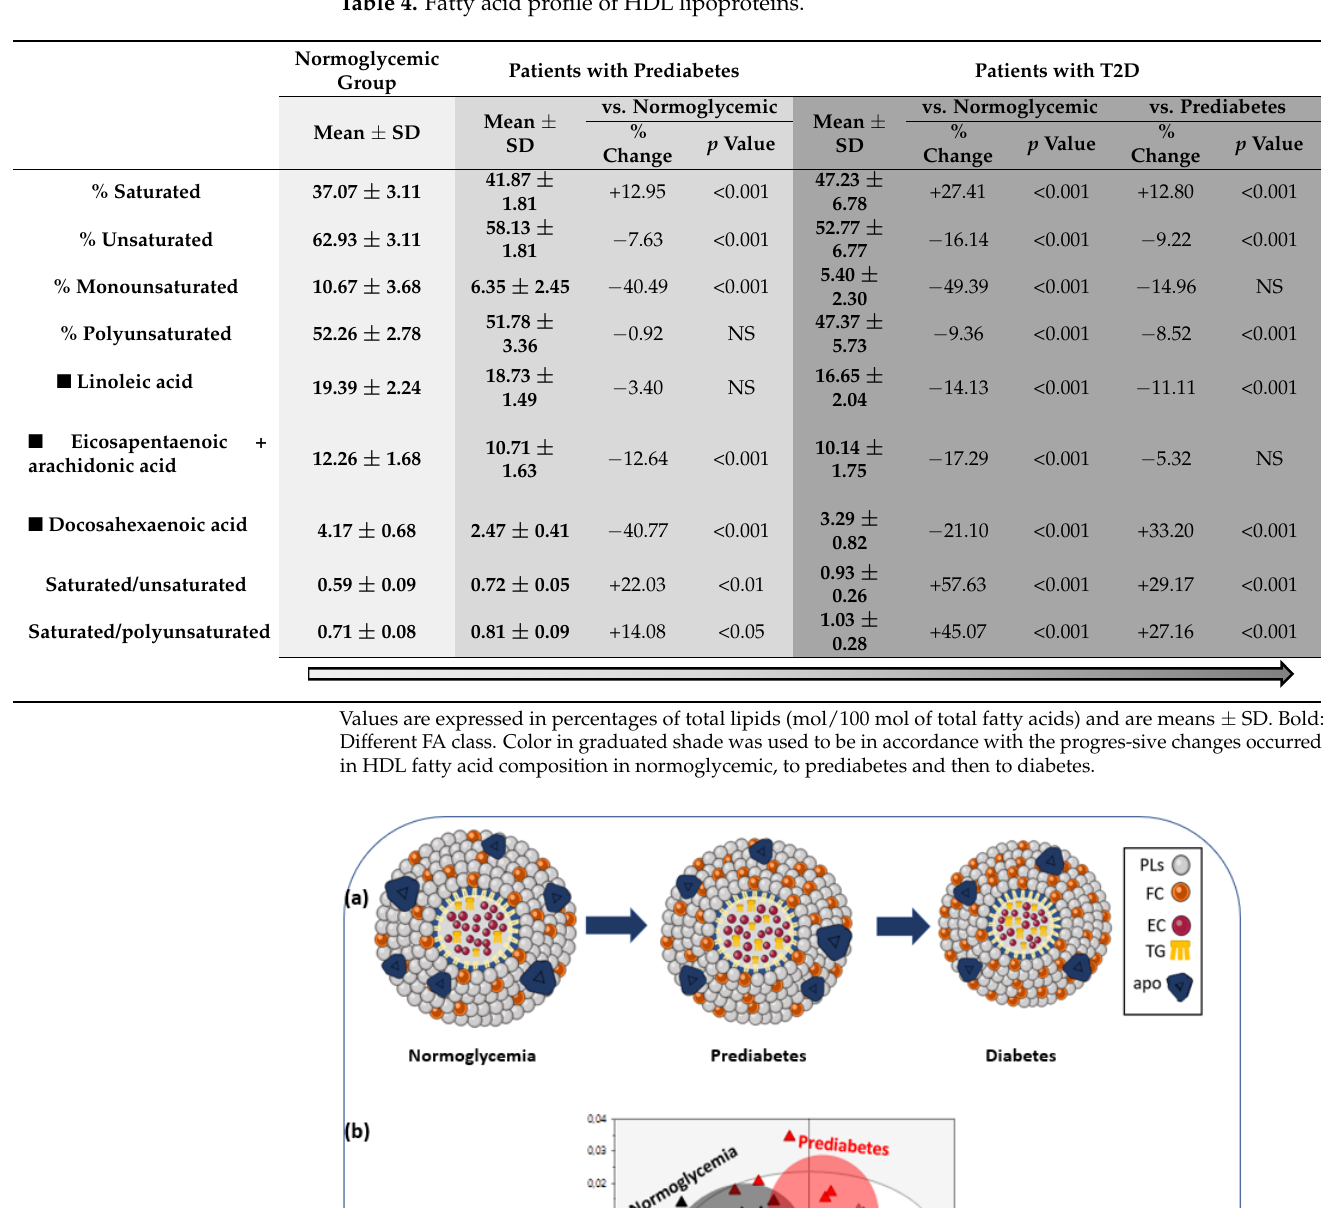
Table 4. Fatty acid profile of HDL lipoproteins.